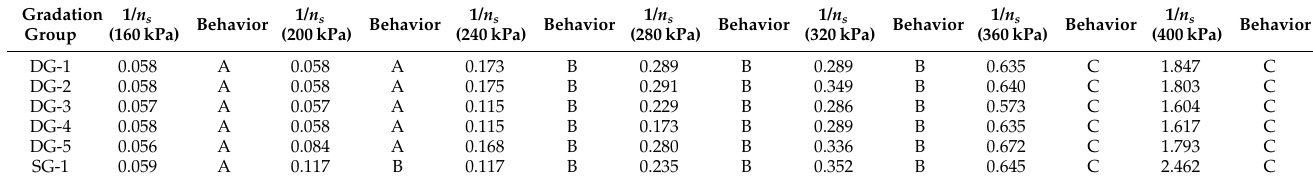
Table 3. Values of 1/ n s value and shakedown behavior of graded crushed stone under different loads. Gradation